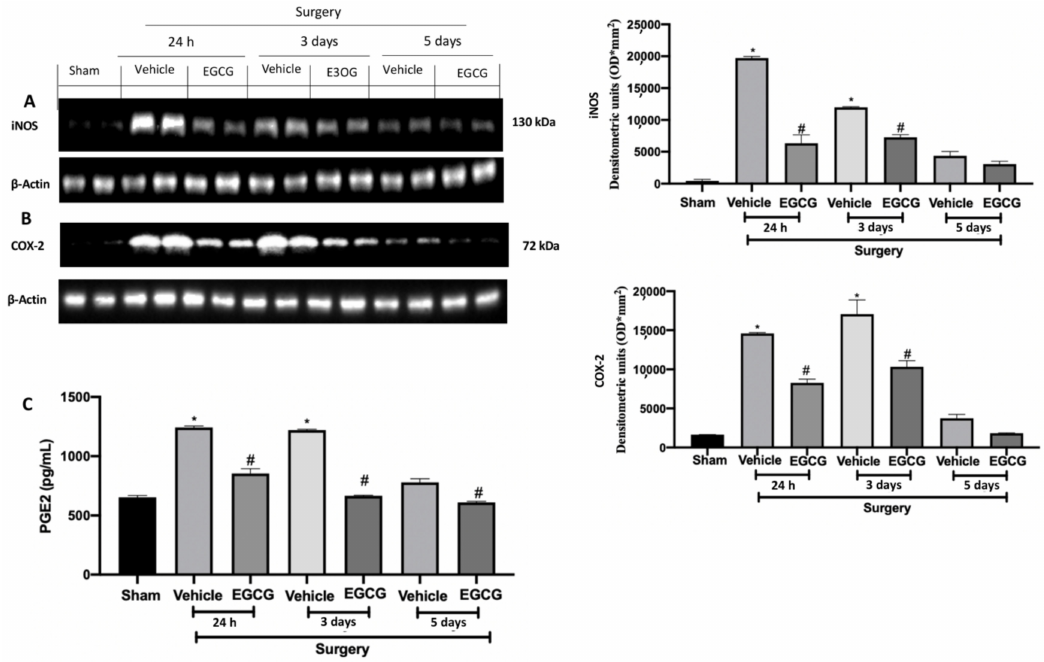
Figure 7. EGCG administration reduced iNOS, COX-2, and PGE2 expression: Western blot analysis of: iNOS ( A ), COX-2 ( B ) expression, PGE2 levels ( C ). A p -value of less than 0.05 was considered significant. * p < 0.05 vs. sham, # p < 0.05 vs.